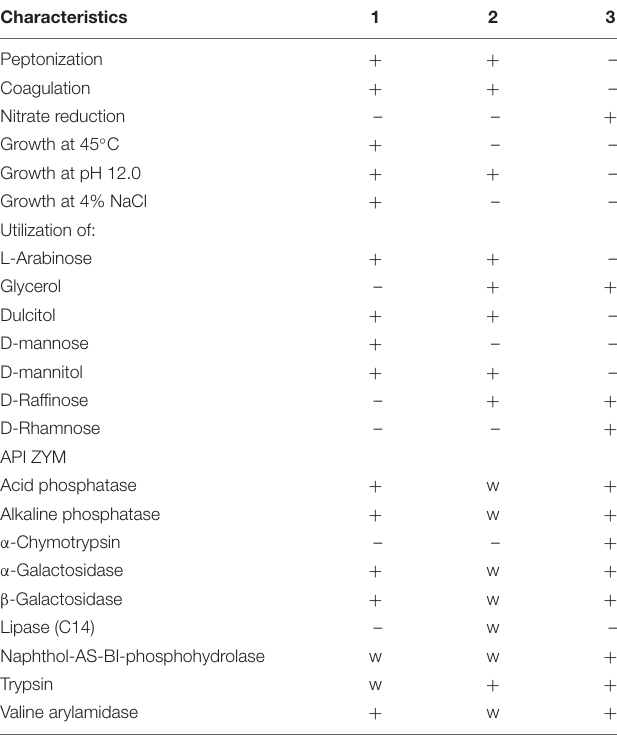
TABLE 6 | Differential phenotypic characteristics of strain CMU55-4 and its phylogenetically closest type strains.